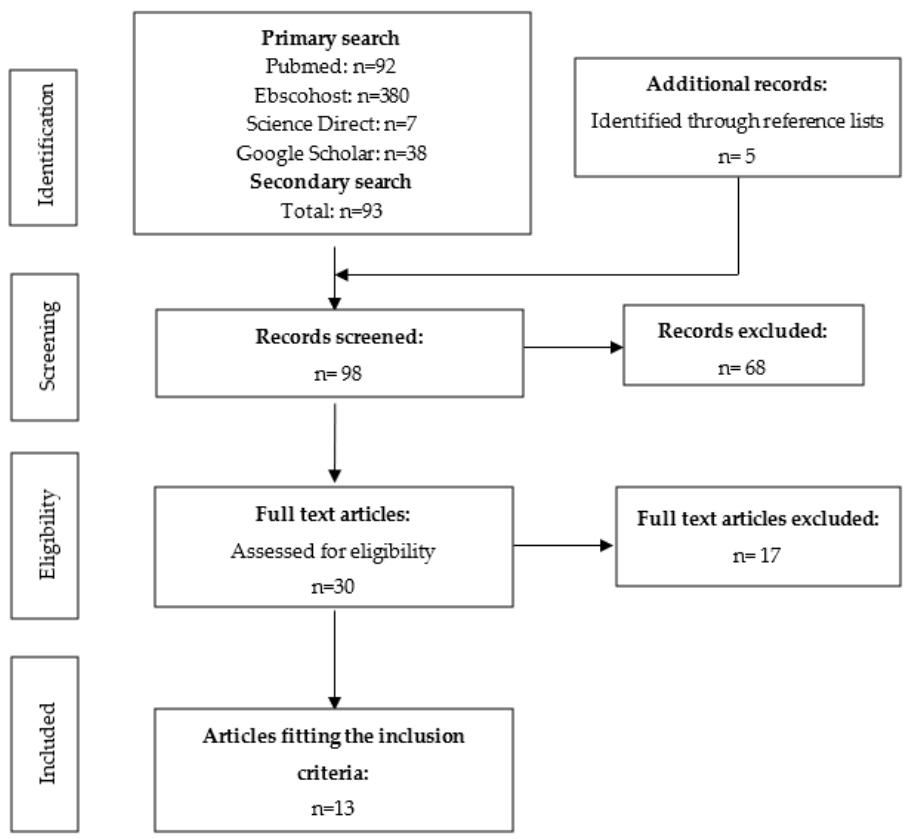
Figure 2. Schematic representation of the flow of information during the different phases of systematic review [52].